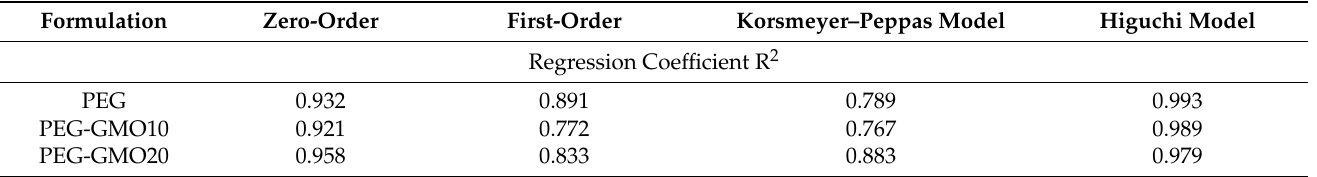
Table 3. Release kinetics models used to describe the release of PAB from PEG-LC formulations.